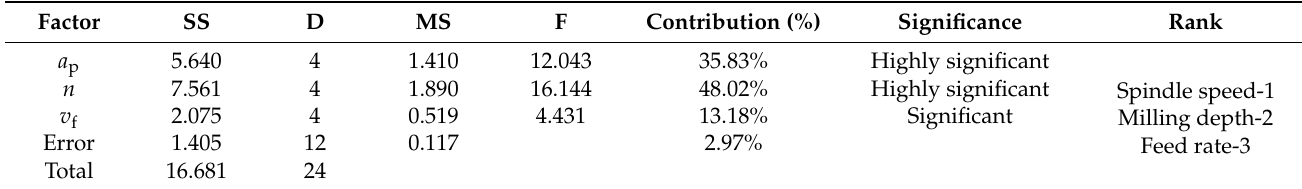
Table 9. Variance analysis results of surface roughness orthogonal experiment.